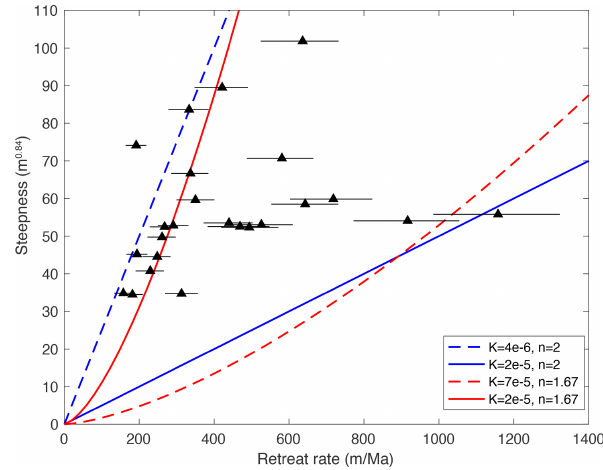
Figure 15. Channel steepness against escarpment retreat rates with 1 σ uncertainty for catchments in the Western Ghats. Retreat rates of the escarpment are calculated using the basin projection method with an azimuth of N57E. Lines are model prediction of steepness and retreat rates from Eq. (2) for a range of the slope exponent n and K where the dimensions of K are m 1 − 0 . 84 n /yr .